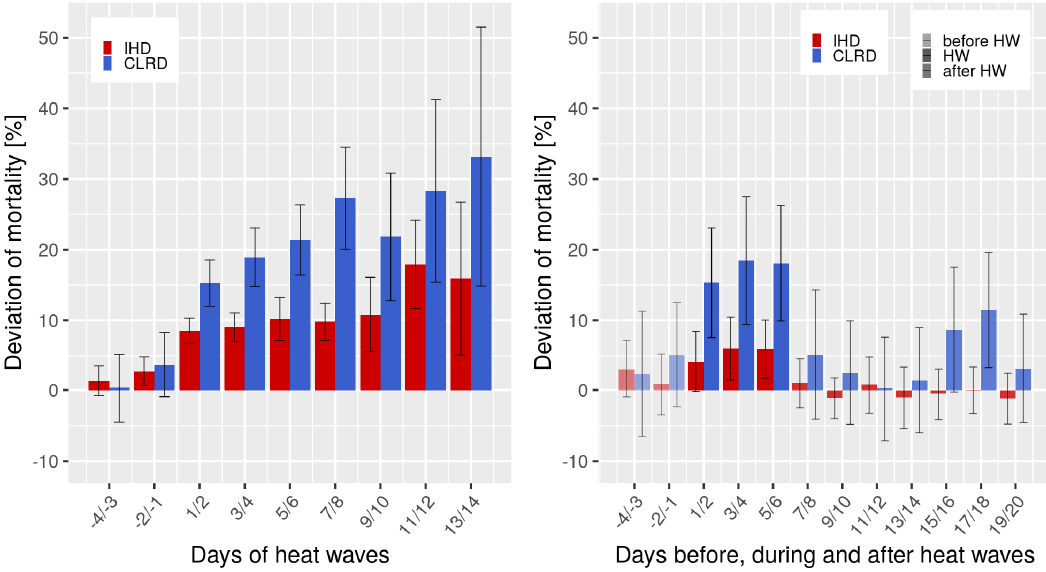
Figure 6. Deviation of CLRD and IHD mortality from the expected value due to heat waves based on T a . Left: Averaged over all heat waves between 2001–2015 in Germany. Right: Days before, during and after 6-day (3 twin-days) heat waves in Germany averaged over the years 2001–2015.